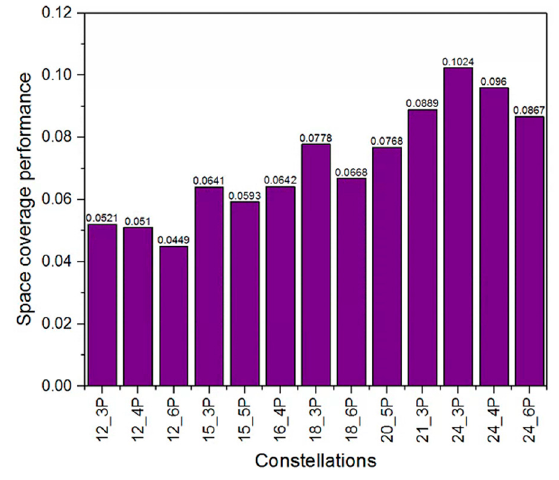
Figure 6. The airspace coverage performance of each constellation.